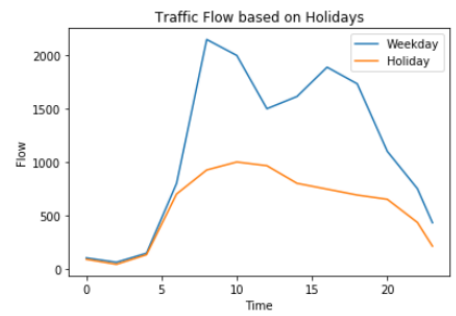
Figure 9. Traffic flow based on